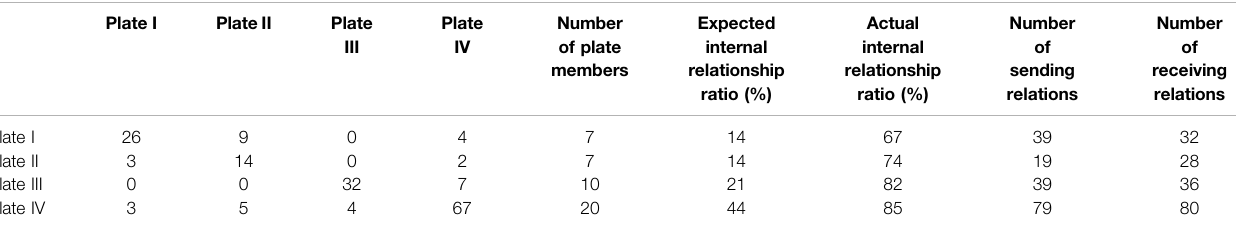
TABLE 3 | Spillover effects of environmental risk contagion among four plates.